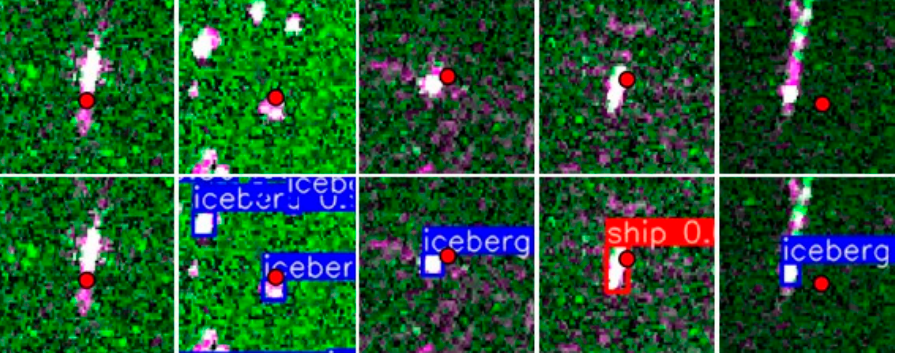
Figure 8. The 5 AIS validation data points in the validation area, top images are the input Sentinel-1 RGB composites and bottom images are the model prediction.